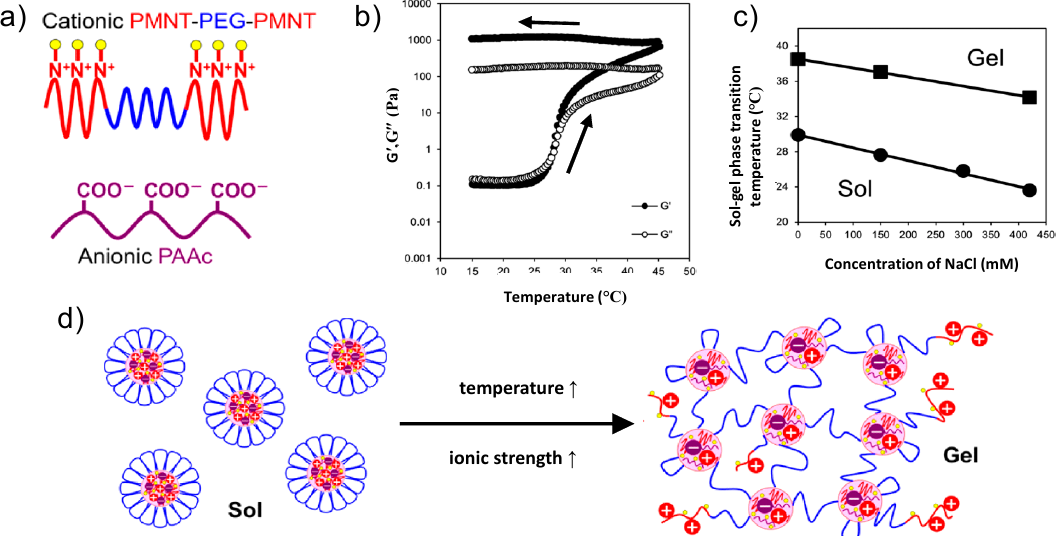
Figure 9. ( a ) Schematics of the polymers MEM and A; ( b ) storage modulus G ′ and loss modulus G ″ of polyion complexes flower micelles (55 mg/mL, r = 1 : 1, 150 mM NaCl, pH 6.2, 550 mM phosphate buffer) with increasing temperature and decreasing temperature, as indicated by the arrows; ( c ) ionic strength dependence (55 mg/mL, r = 1 : 1 , pH 6.2): concentration of phosphate buffer 330 mM (closed squares) and 550 mM (closed circles); and ( d ) schematics of the solution of the polyion complexes micelles and the irreversible gel formation upon increasing temperature and ionic strength. Adapted with permission from [40]. Copyright 2015 American Chemical Society.